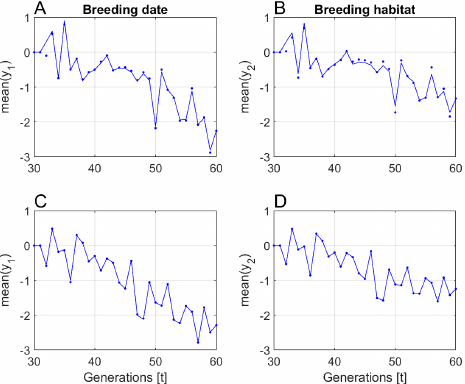
Figure 2: Typical input signals for simulation example, with three noisy ramp functions starting at generation t = 10 (1970). Here, µ U is a 1 ,t ramp function and µ U = 2 (dashed ma- 2 ,t genta lines), while µ Θ = − 2 ( µ U − 10) 1 ,t 1 ,t and µ Θ = − ( µ U − 10) (dashed magenta 2 ,t 1 ,t lines). Other numerical values are σ 2 = U 1 ,n 0 . 5, σ 2 = 2 and σ Θ = − 0 . 25 (as in Θ 1 ,n 1 ,n U 1 ,n Ergon, 2022), and σ U = = 0 . 25, σ 2 U 2 ,n 1 ,n U 2 ,n 0 . 25, σ 2 = 0 . 25 and σ Θ = − 0 . 25. Θ 2 ,n 2 ,n U 2 ,n